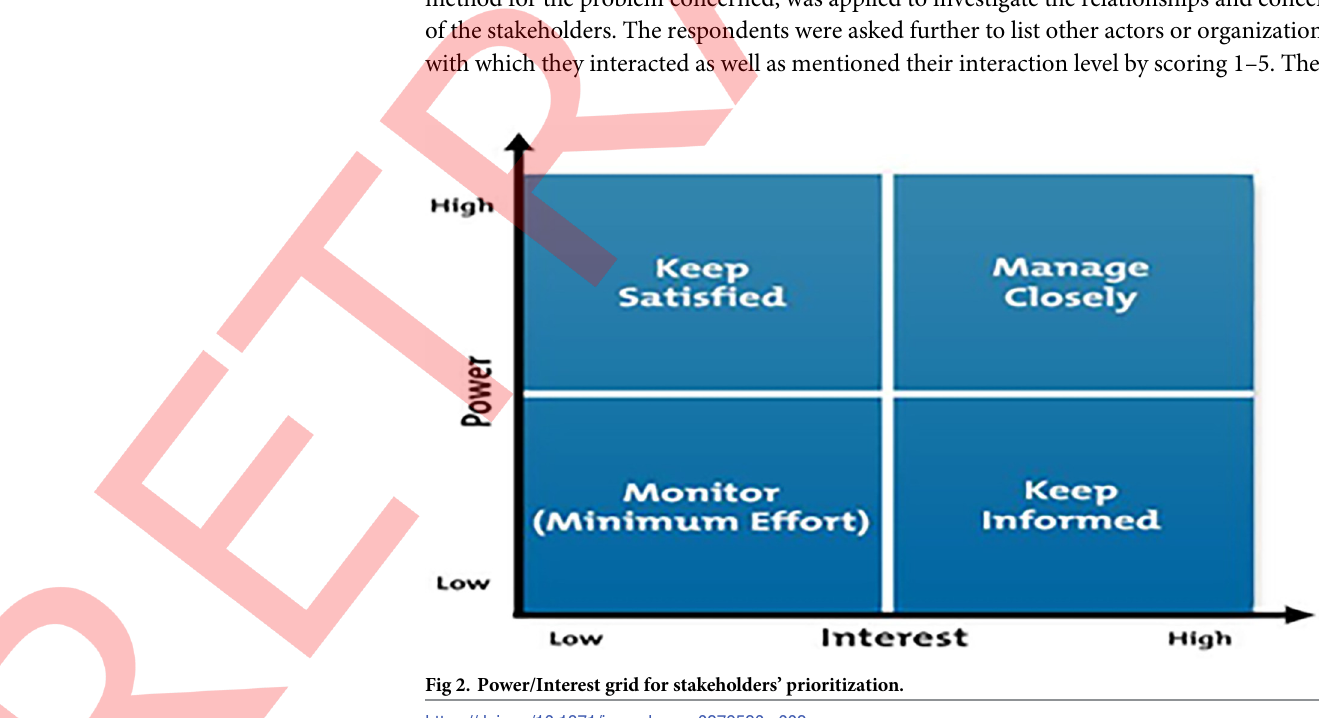
Fig 2. Power/Interest grid for stakeholders’